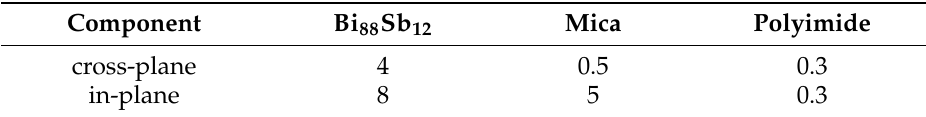
Table 4. Thermal conductivity, W/m ·